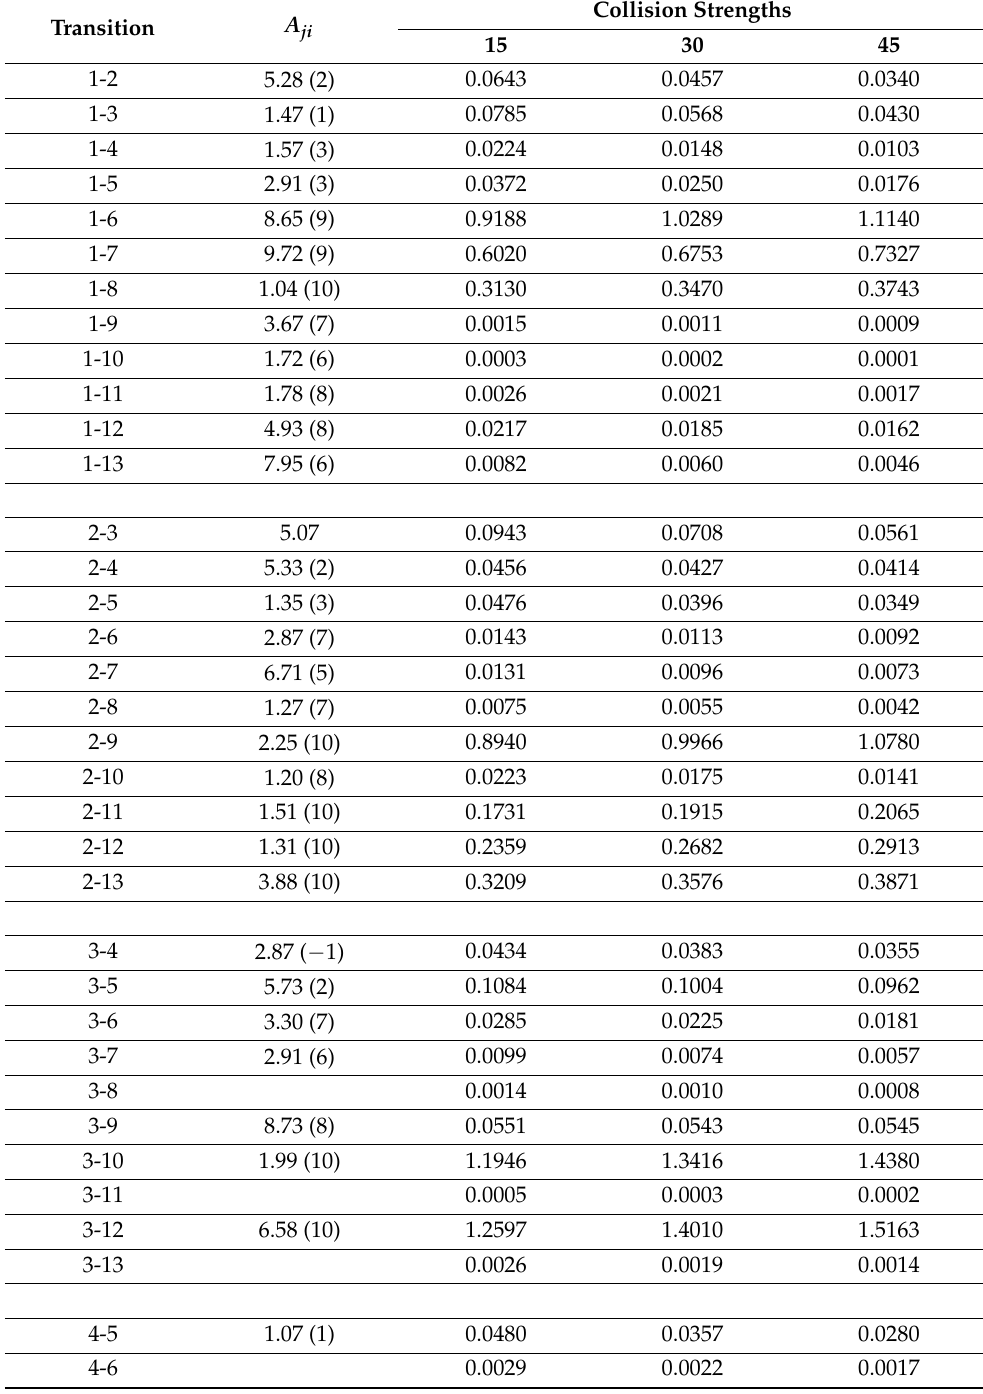
Table 2. Radiative rates (s − 1 ) and collision strengths at various incident energies (Ry) for Ca XIV. Transition A